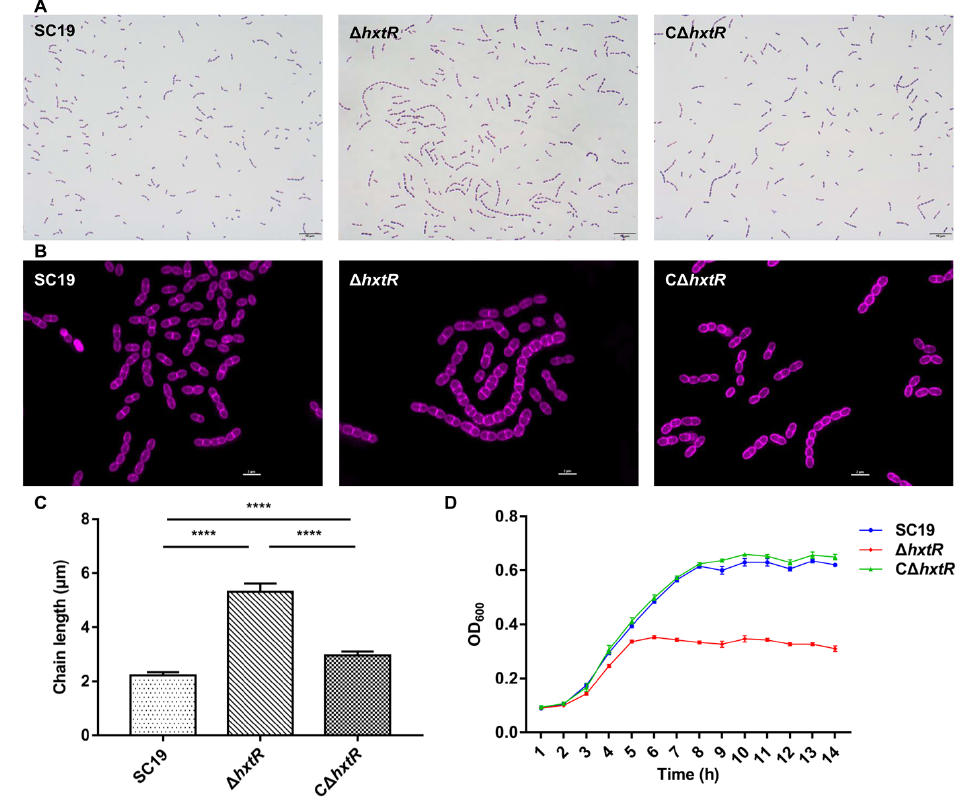
Figure 4. Cell morphology and growth characterizations of Δ hxtR , C Δ hxtR, and SC19 strains. ( A ) Morphological analysis by Gram staining. The cells of each indicated strain were grown to the mid-log phase, washed, subjected to regular Gram staining, and imaged under a light microscope. The scale bar is 10 µm. ( B ) Morphological analysis with SIM. The cells of each indicated strain were grown to the mid-log phase, washed, stained with fluorescent dye Alexa Fluor 647, and imaged using a two-color structure illumination microscope (SIM; Nikon Instruments, Tokyo, Japan) with excitation at 651 nm and emission at 672 nm. ( C ) Comparison of bacterial chain length. Over one hundred chains per sample were randomly selected in different fields from the Gram staining images to measure the length of the chain by using the software Image-Pro, and then the average chain length was calculated (in µm) and statistically analyzed using the Student’s t -test. **** indicates p < 0.0001. ( D ) Growth assay. The overnight cultures of the strains were diluted to an initial OD600 of 0.01 with TSB, and then, the diluted culture was pipetted into a microplate. The plate was incubated at 37 °C with continuous shaking for 14 h, and the optical density at 600 nm was monitored every 1 h.